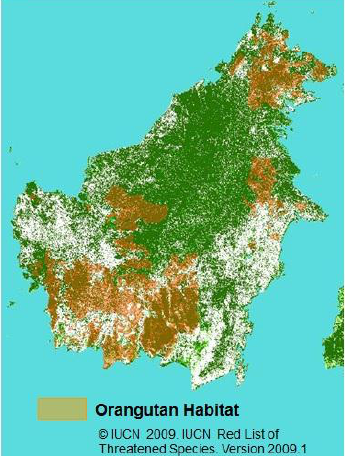
Figure 11: Global Map for biodiversity conservation